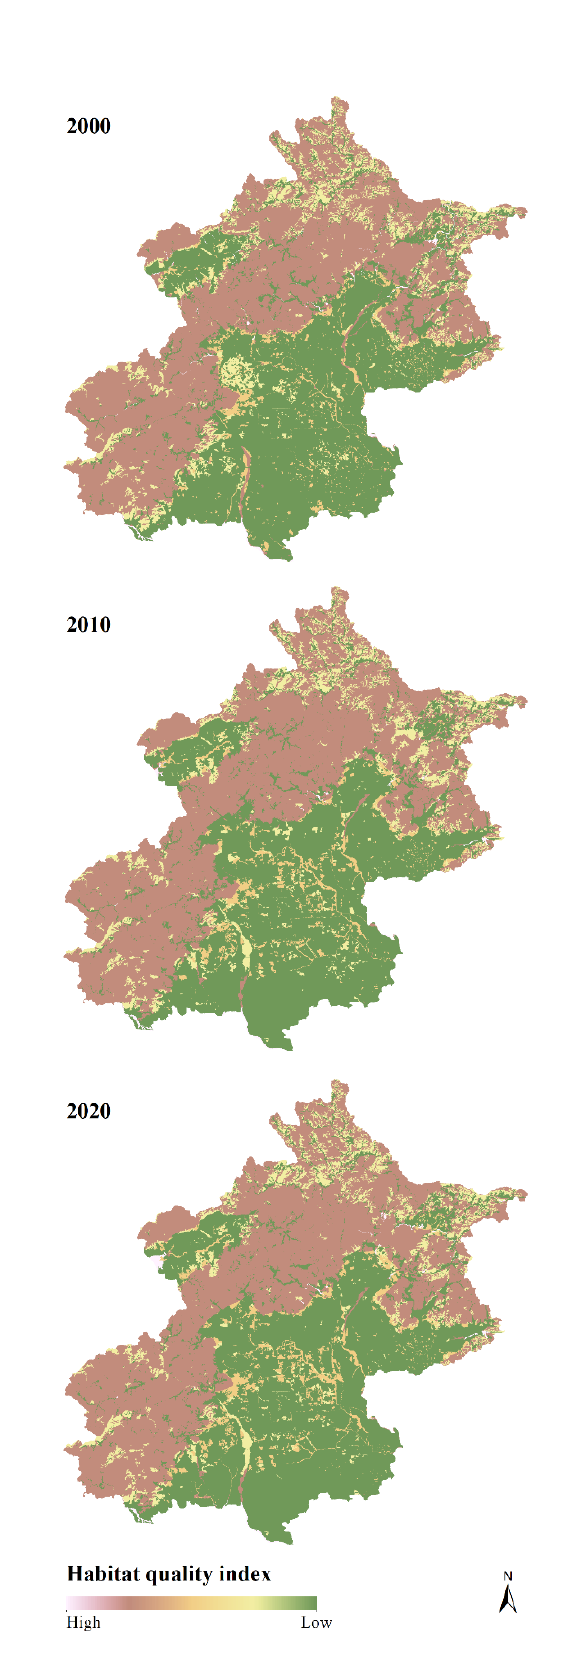
Figure 5 . Spatial distribution of habitat quality from 2000 to 2020 in